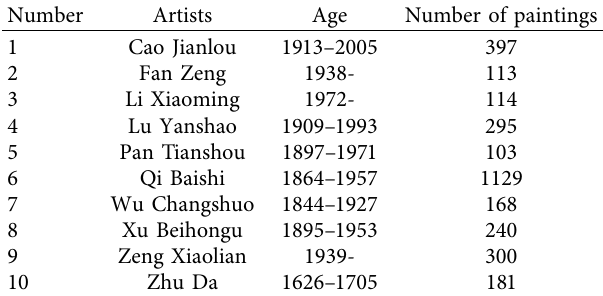
Table 1: The dataset of Chinese IWPs by ten